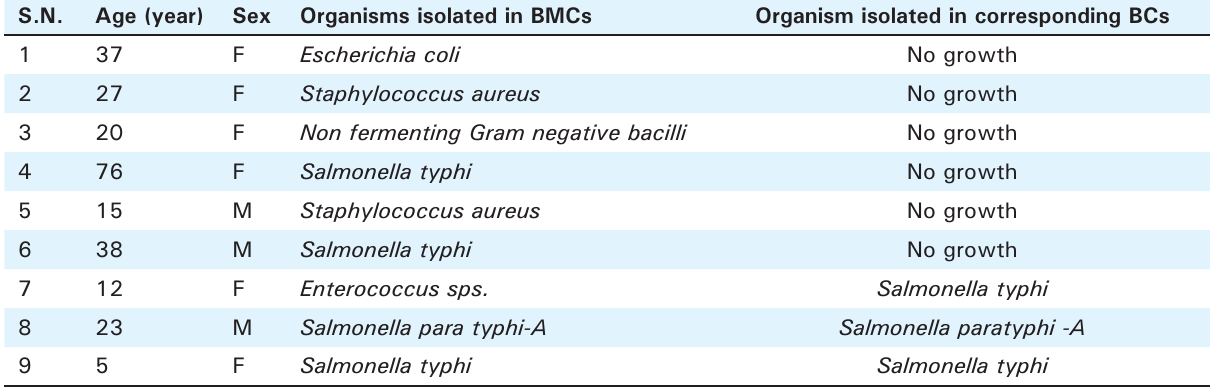
Table 3. Result of bone marrow culture